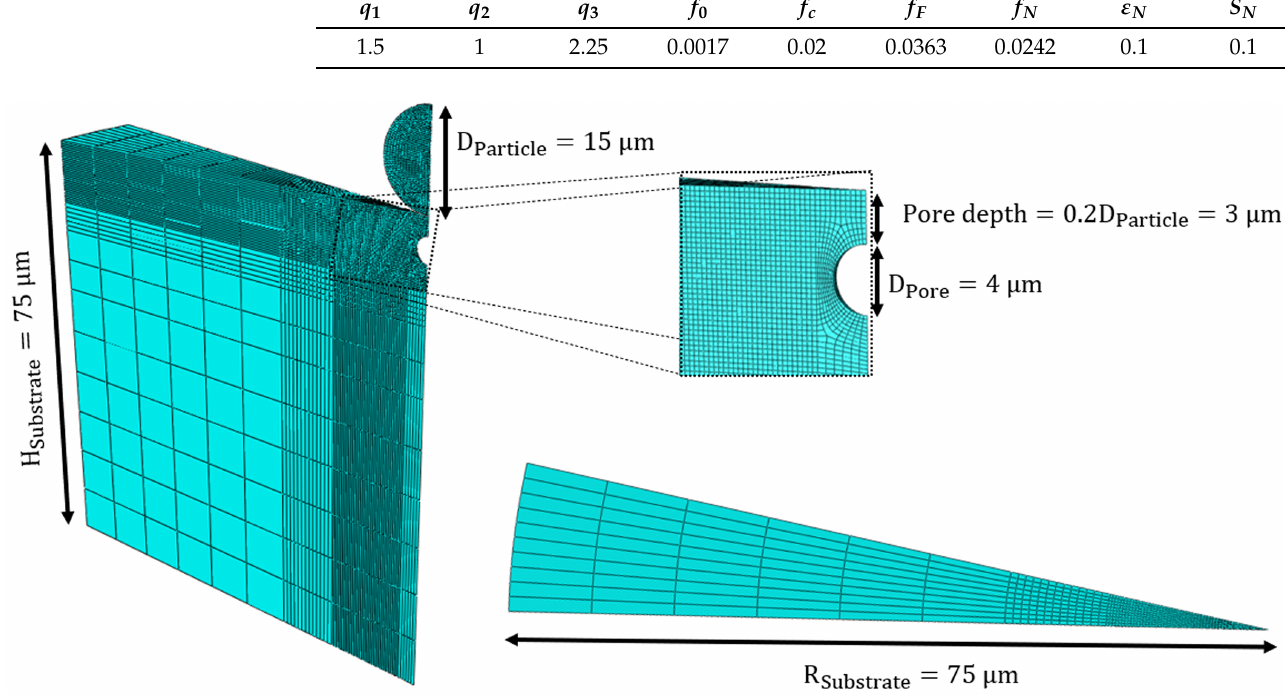
Figure 1. Three-dimensional numerical model geometry for simulating a single particle impact during the cold spray deposition